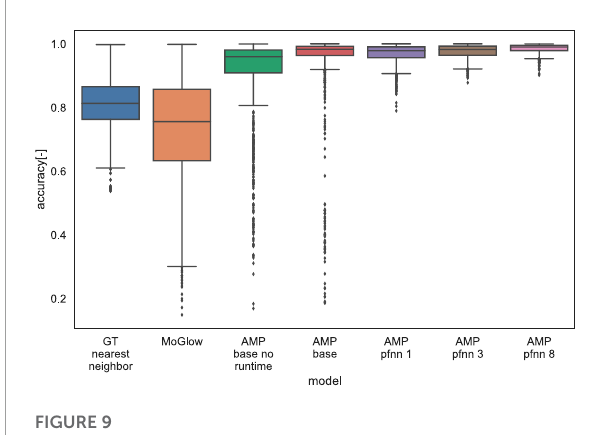
FIGURE 9 Comparison of objective evaluation results of normalized pointing accuracy for the different